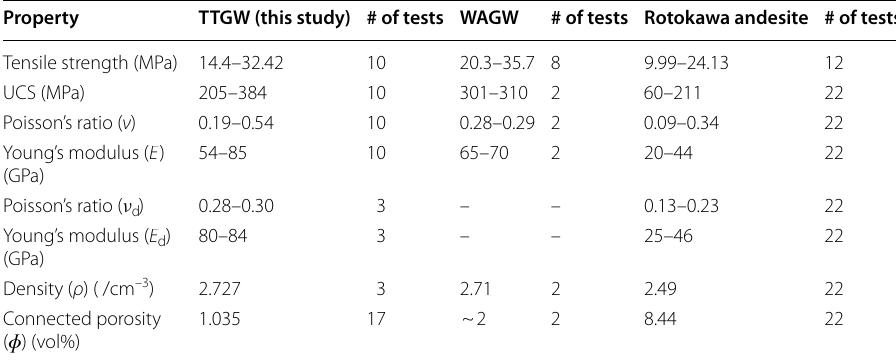
Table 3 A comparison of the physical and elastic properties values for Waipapa greywacke samples ( TTGW Taotaoroa Quarry; WAGW Waotu Quarry) measured in this study [this study; McNamara et al. 2014) and Torlesse greywacke (this study (connected porosity); McNamara et al. 2014; Stewart 2007), Rotokawa andesite (Siratovich et al. 2012, 2014)